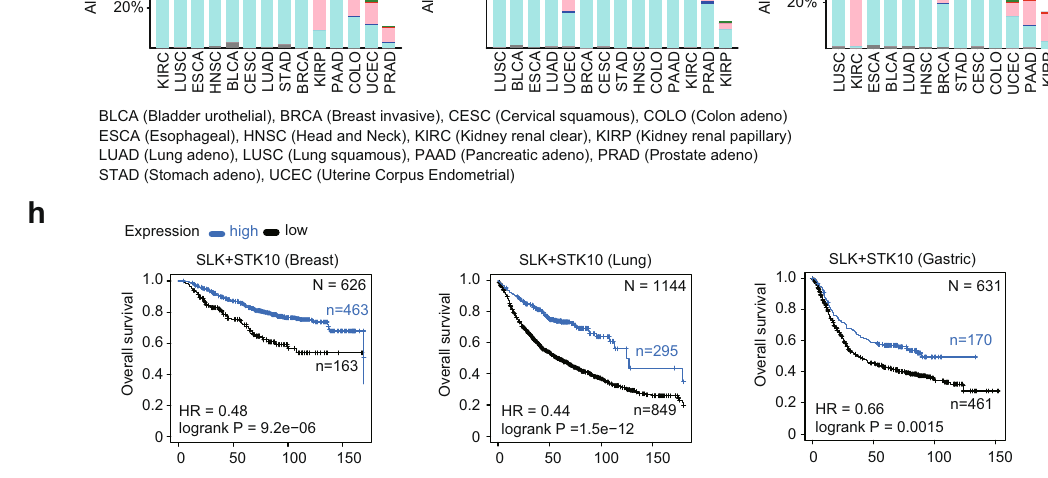
MutationAmplification GainDeletion Loss Multiple